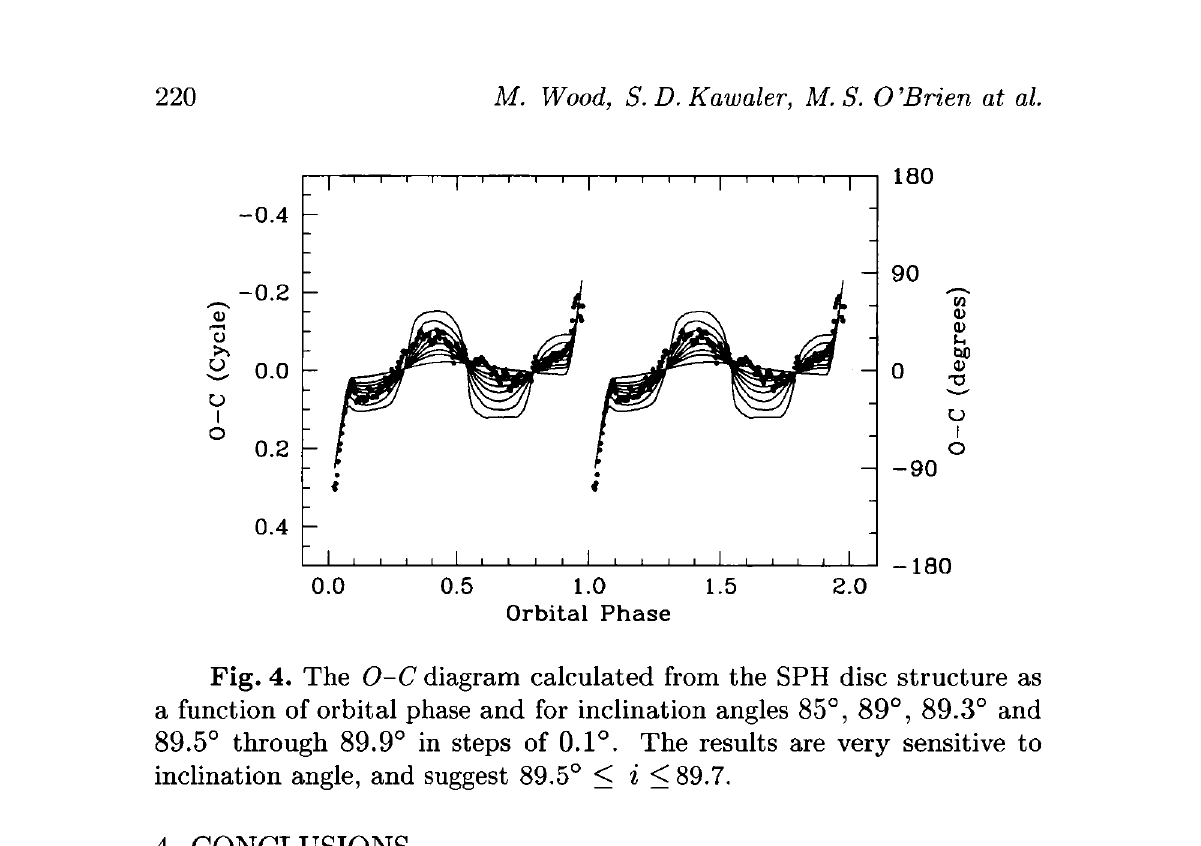
Fig. 4. The O-C diagram calculated from the SPH disc structure as a function of orbital phase and for inclination angles 85°, 89°, 89.3° and 89.5° through 89.9° in steps of